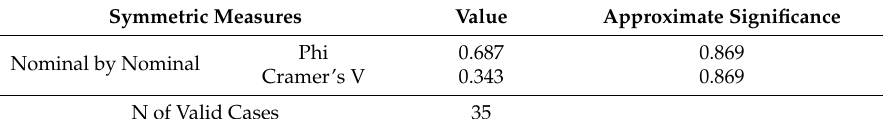
Table A4. Symmetric measures: Game * Age.